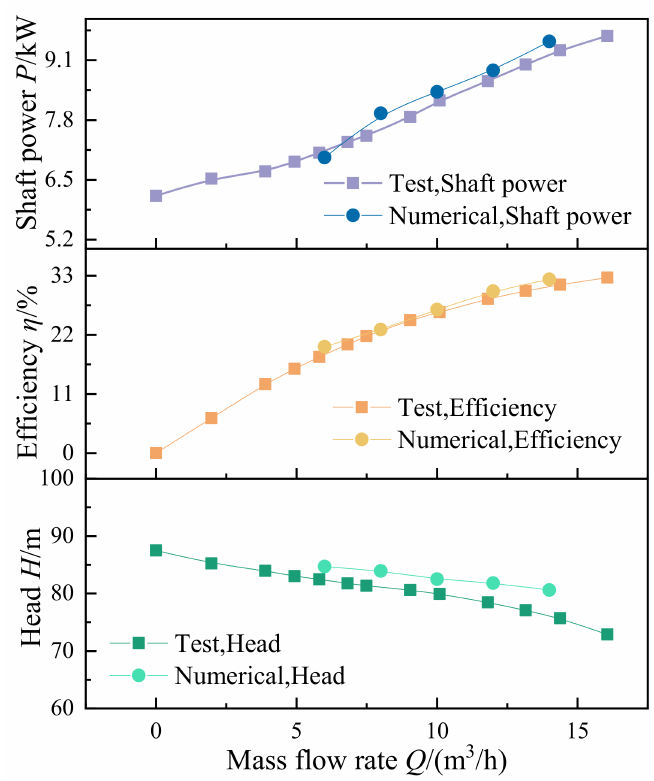
Figure 5. Comparison between simulation results and test